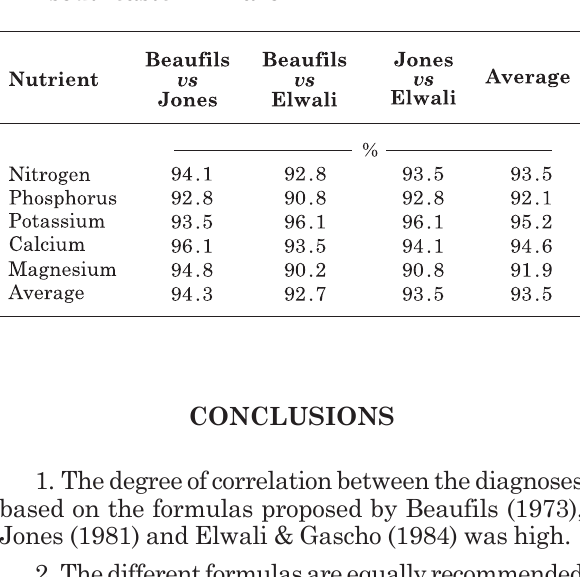
Table 6. Degree of agreement of nutritional diagnoses among DRIS formulas developed by Beaufils (1973), Jones (1981) and Elwali & Gascho (1984), in 153 cupuaçu orchards in the southeastern